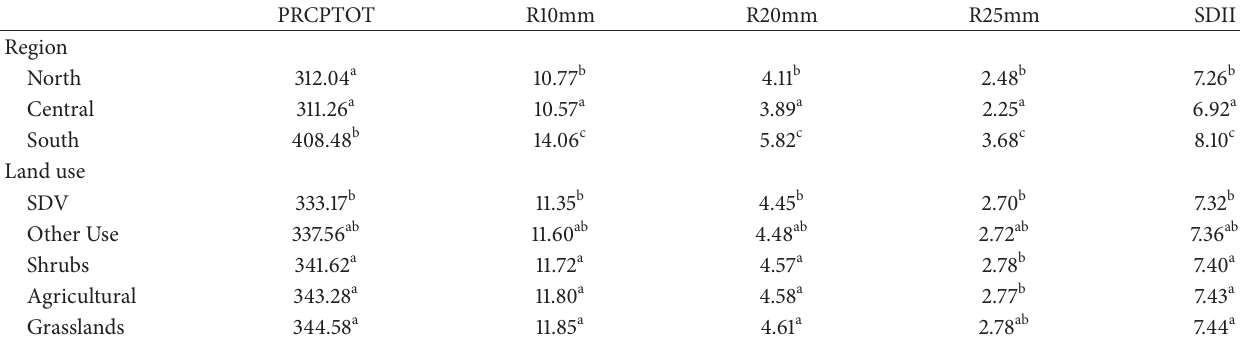
Table 5: The Bonferroni test for homogeneous groups ( 𝛼 = 0.05 ) by region and by land